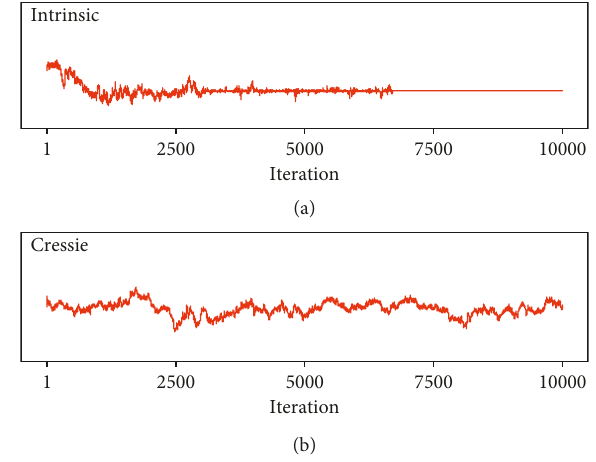
Figure 3: Illustration of Bayesian model convergence: intrinsic (a) and Cressie